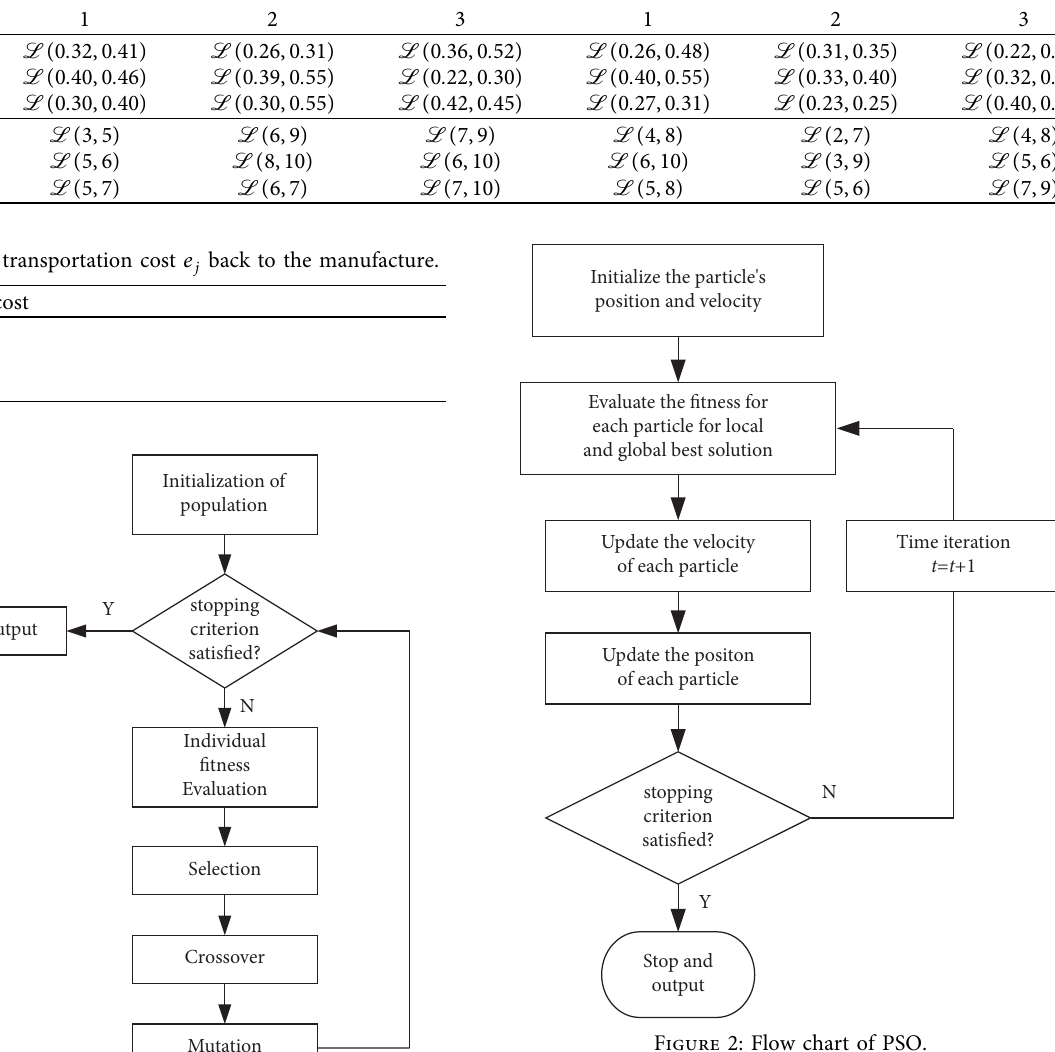
ijk and fixed charge